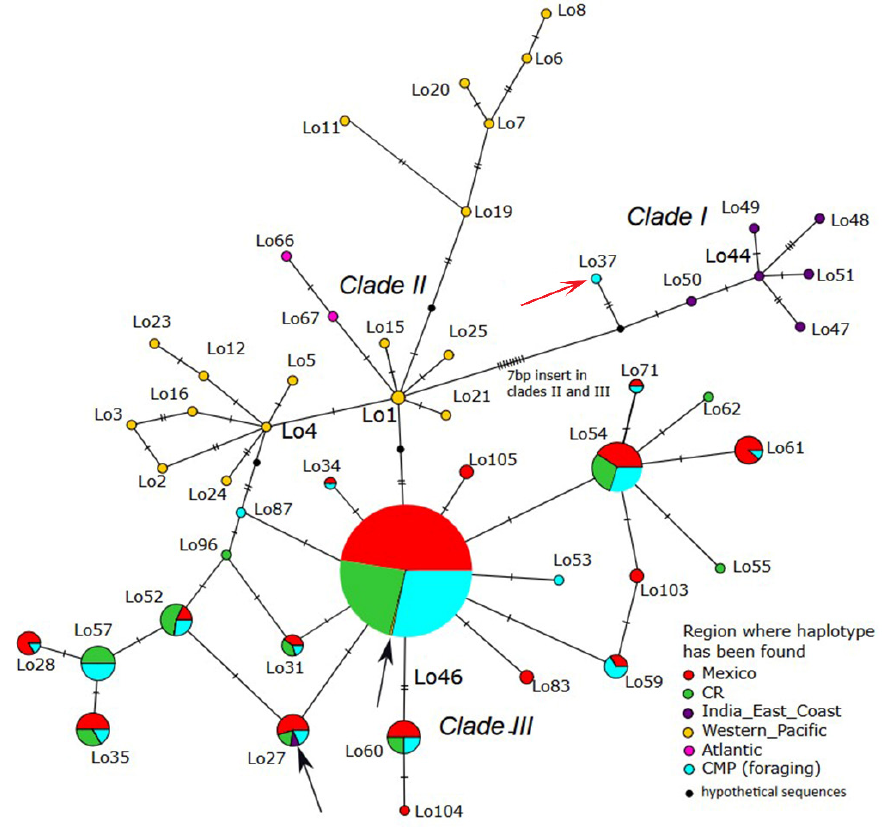
Figure 2. Minimum spanning network (MSN) for mtDNA control region haplotypes of olive ridleys sampled in the Central Mexican Pacific (CMP) and reported worldwide. Haplotypes from the CMP (in turquoise) were grouped in Clade III and Clade I. Clade I: East coast of India; Clade II: Western Pacific and Atlantic; Clade III: Eastern Pacific. Circles indicate haplotypes with sizes proportional to their relative frequency in Supplementary File S2. Black arrows indicate haplotypes of Eastern Pacific origin found on nesting beaches of the Western Pacific and East coast of India; red arrow indicates the single Clade I haplotype also exhibiting the 7 bp deletion characteristic of this